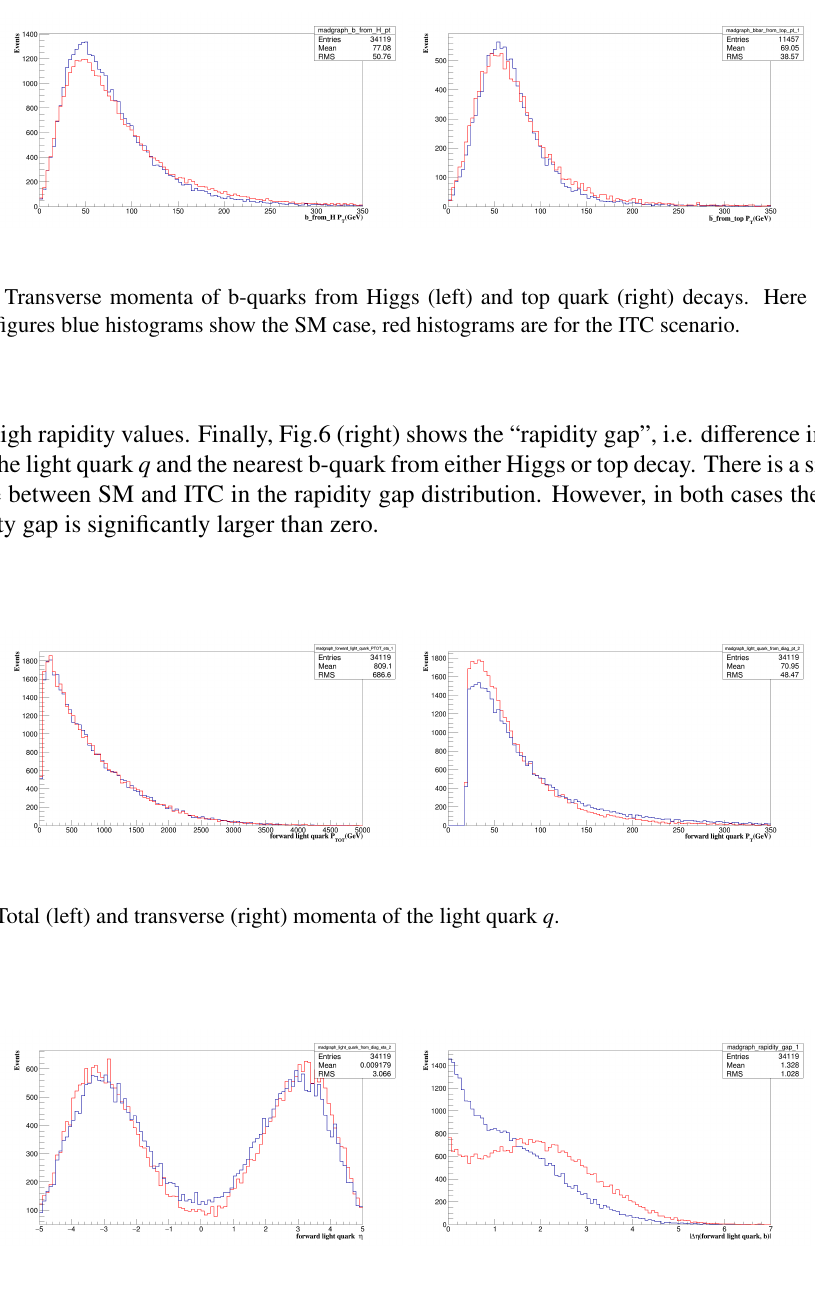
Figure 6. Rapidity of the light quark q (left) and the rapidity gap (right).